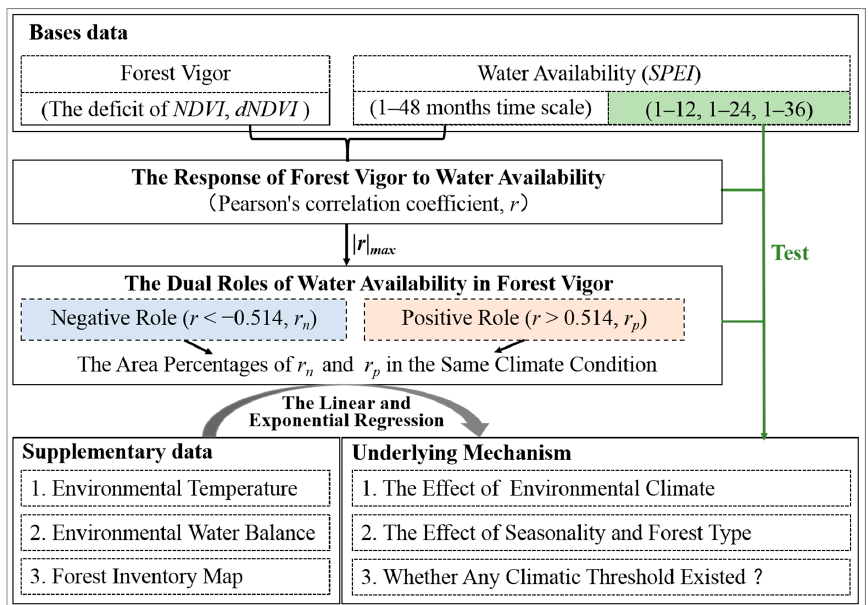
Figure 3. Flow diagram of the analysis used in this